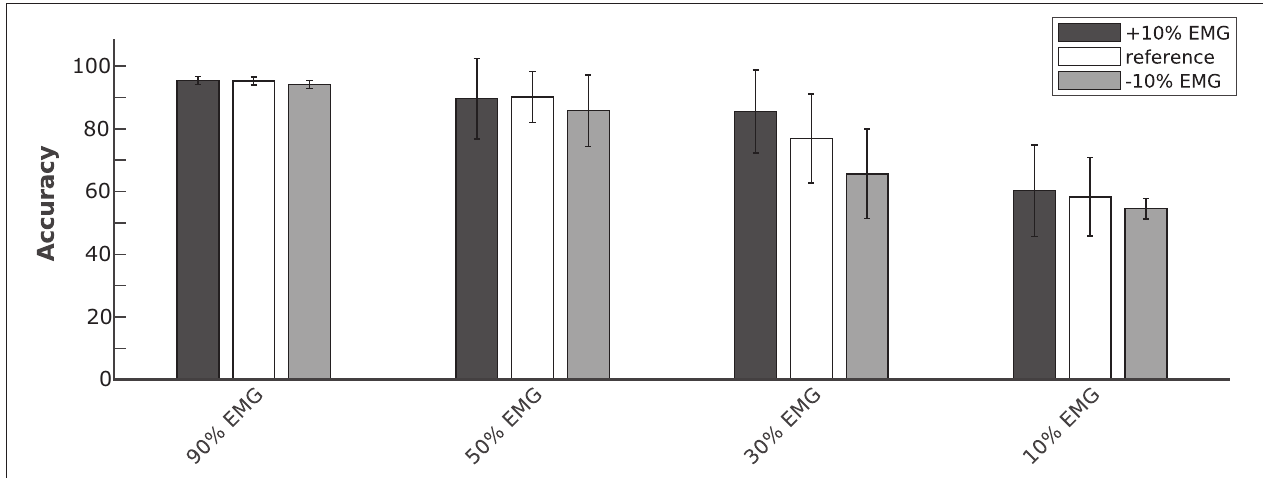
FIGURE 6 | Average classification accuracy of the hybrid approach at four levels of temporary EMG alteration (90, 50, 30, and 10% EMG amplitude). The Bayesian fusion method provides comparable performance when the level of alteration is precisely known a priori, meaning the same attenuation is applied to both validation and test set (white bars), with respect to when the test set has a different attenuation level of + 10 % (dark gray bars) or − 10 % (light gray bars) of EMG signal amplitude than the validation